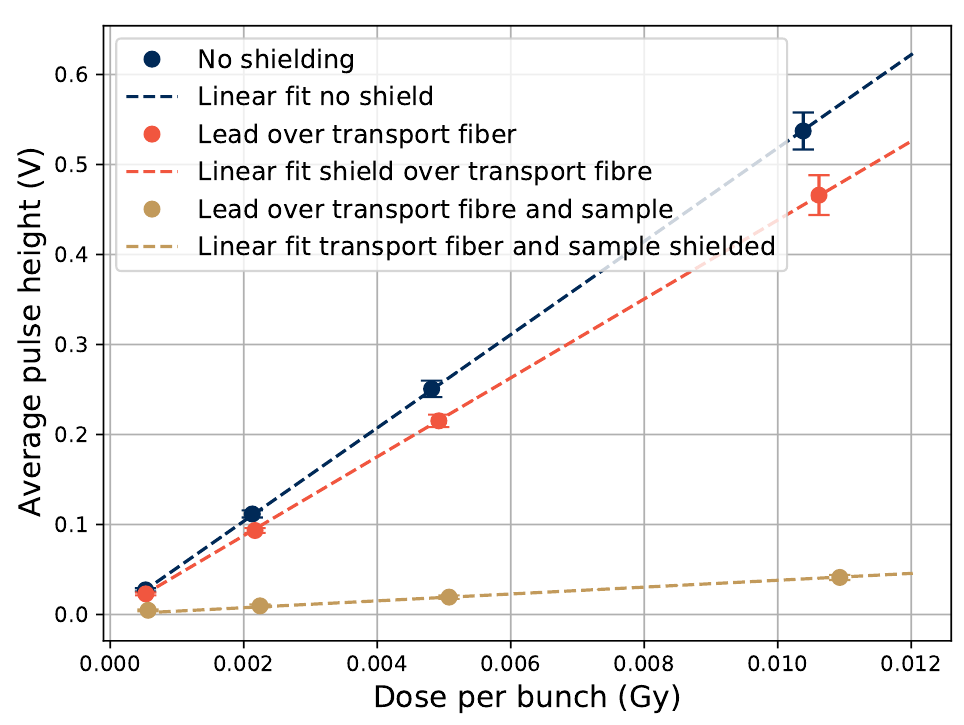
Figure 9. Pulse height as a function of electron bunch size in the Gd-doped sample at different shielding configurations using 5-cm thick lead